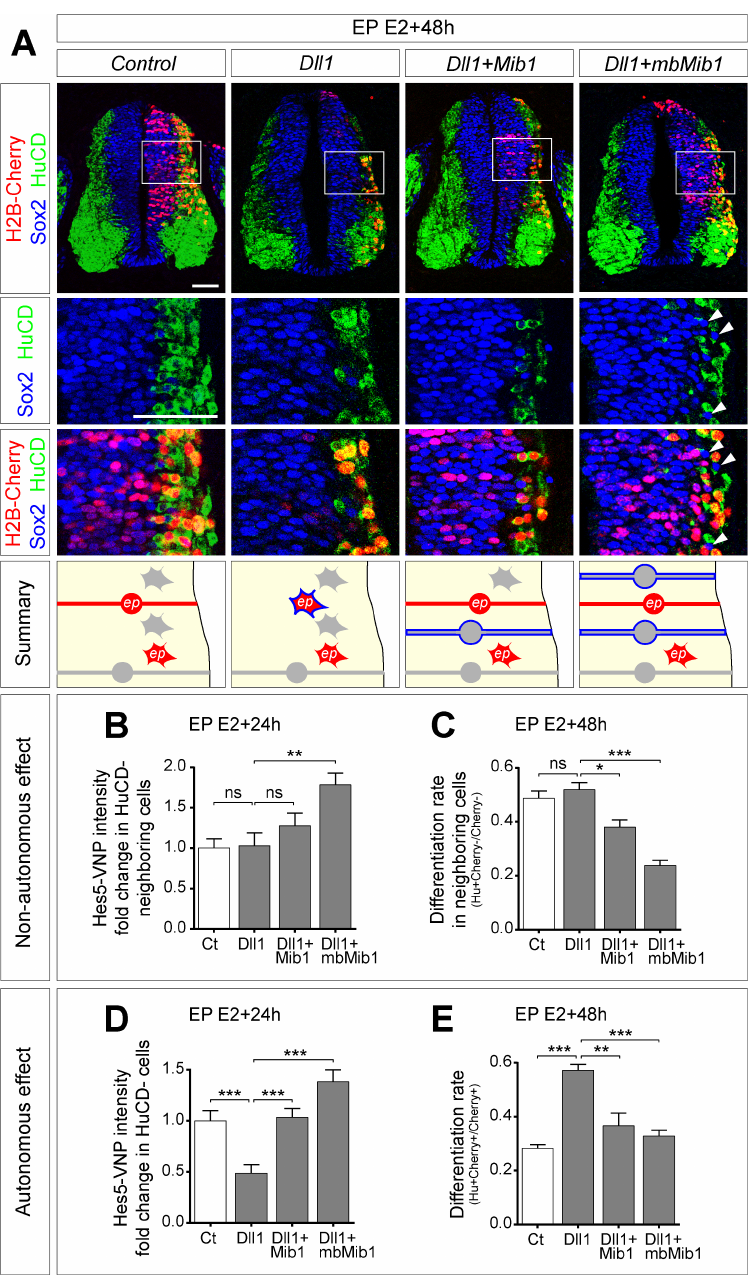
Fig 4. Mib1 blocks the ability of Dll1 to Cis -inhibitNotch signaling. (A) Top: Transverse sections of the NT transfected at E2, with the indicated constructs and harvested at E4. Immunostaining for Sox2 (blue) and HuCD (green) labels progenitors and neurons, respectively. Transfection is reported by H2B-Cherry expression. Arrowheads indicate ectopic Sox2 + progenitors adjacent to HuCD + transfected neurons. Bottom: Summaries of the effects of Dll1 and Mib1 on neurogenesis. Red and gray cells correspond to electroporated (ep) and non-electroporated cells, respectively. Round and star-shaped cells correspond to progenitors and neurons, respectively. Blue outlines indicate cells changing fate, autonomously or non-autonomously, in each condition. (B, D) Quantification of the Hes5-VNP signal intensity in HuCD − cells either (B) non-transfected (surrounded by at least four transfected cells) or (D) transfected 24 hae with the indicated constructs. Data represent fold change compared to control. (B) n = 54, 35, 35, 54 cells were analyzed for control, Dll1, Dll1+Mib1, and Dll1+mbMib1, respectively. (D) n = 58, 59, 59, 66 cells were analyzed for control, Dll1, Dll1+Mib1, and Dll1+mbMib1, respectively. Data were collected from four to six embryos for each experimental group. ns, p > 0.05; (cid:3)(cid:3) p < 0.01; (cid:3)(cid:3)(cid:3) p < 0.001 (Kruskal-Wallis test). (C, E) Quantification of the differentiation rate in (C) non-transfected neighbors (number of non-transfected HuCD + cells adjacent to a HuCD